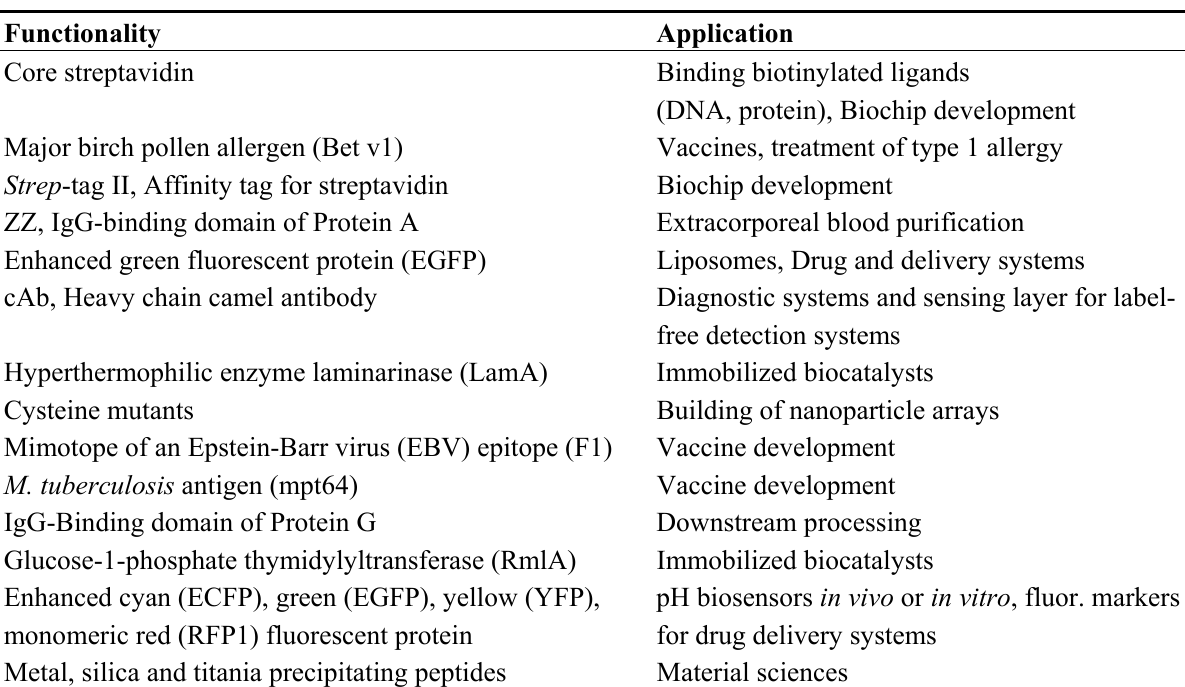
Table 1. Overview of functional domains fused to S-layer proteins and their application [47,48].